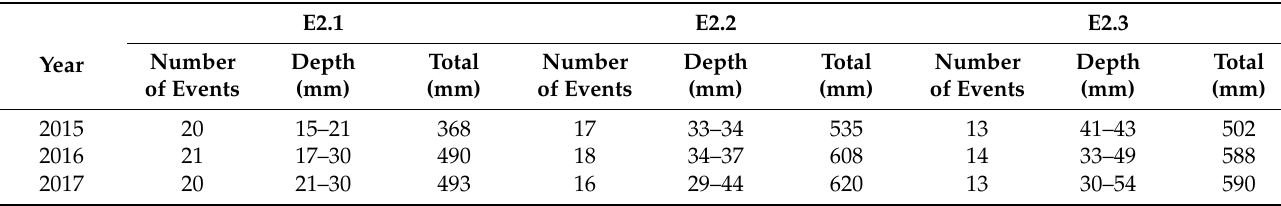
Table 5. Irrigation depths and events during the E2